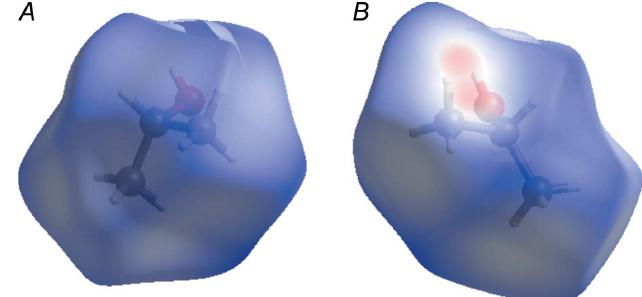
Figure 5 Two-dimensional-fingerprint plots and contributions of the contacts in the title compound [( a ) C (cid:2)(cid:2)(cid:2) H/H (cid:2)(cid:2)(cid:2) C, ( b ) O (cid:2)(cid:2)(cid:2) H/H (cid:2)(cid:2)(cid:2) O and ( c ) F (cid:2)(cid:2)(cid:2) H / H (cid:2)(cid:2)(cid:2) F] and the isopropyl alcohol molecule ( d ) for position A